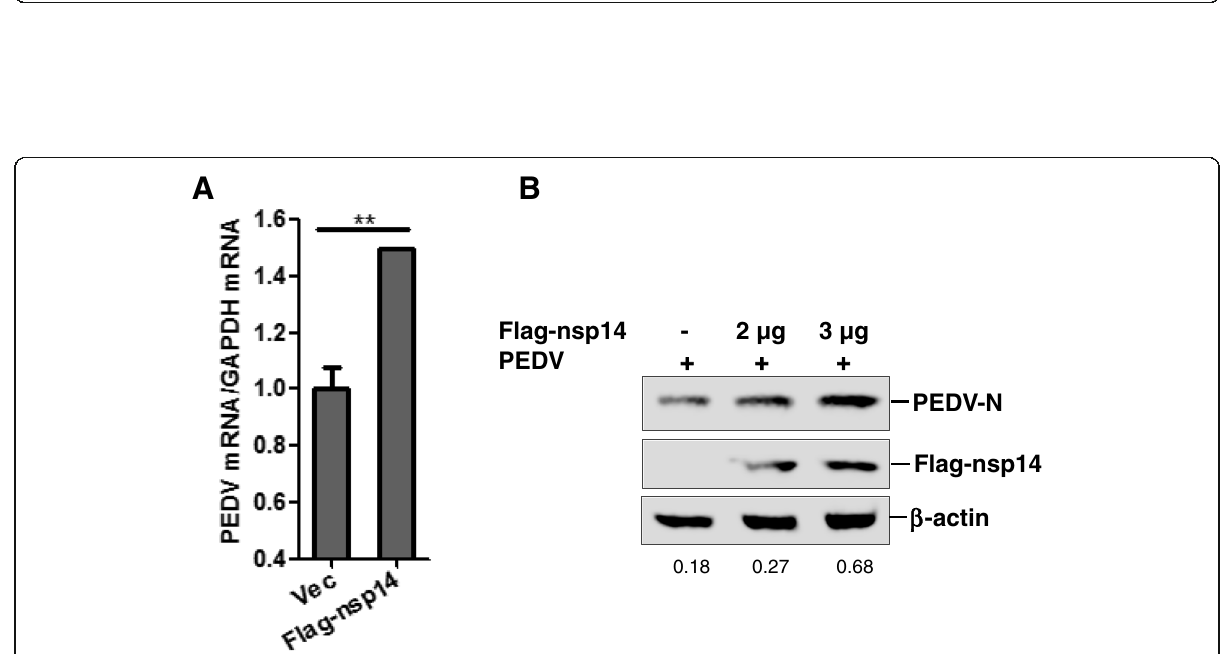
Fig. 7 PEDV nsp14 promotes PEDV replication. A PK-15 cells were transfected with 2 μ g vector plasmids or Flag-nsp14 expression plasmids. At 24 hpt, cells were infected with PEDV at an MOI of 1 for 18 h. The cells were then collected and subjected to qPCR analysis. B Western blotting analysis of transfected PK-15 cells using the indicated antibodies. The relative abundance of PEDV N protein was determined by densitometric analysis using ImageJ software